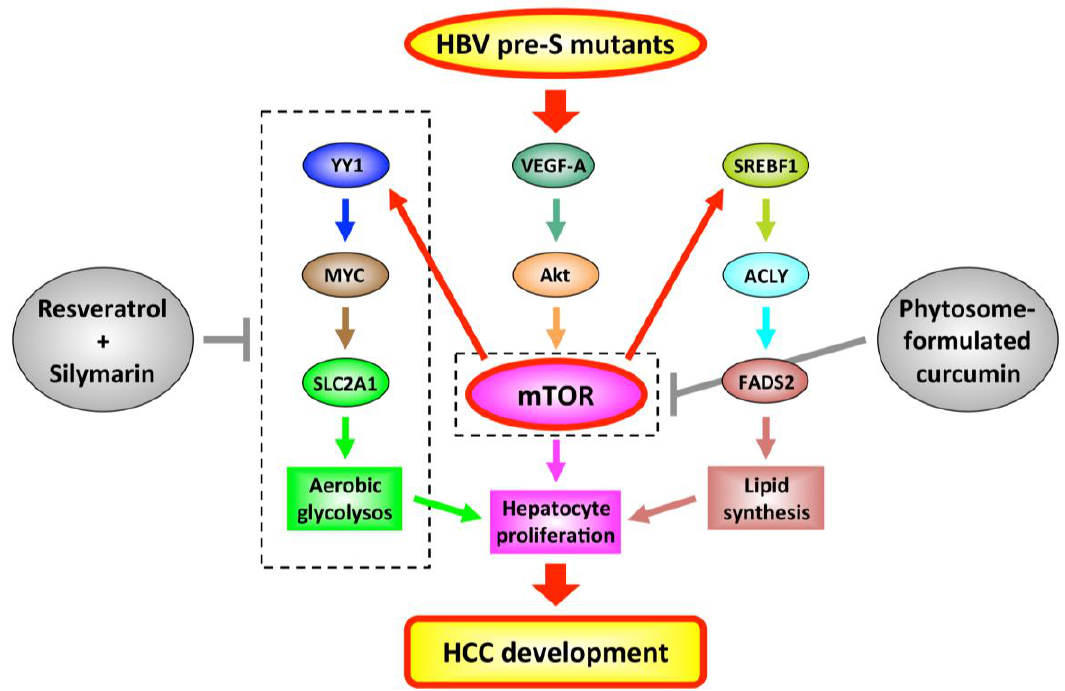
Figure 1. Schematic representation of HBV pre-S mutants-activated mTOR signal pathways as potential targets for HCC chemoprevention. In chronic HBV infection, pre-S mutants can upregulate the expression of vascular endothelial growth factor-A (VEGF-A) in GHHs. Through binding to its cognate receptor, the upregulated VEGF-A functions in either autocrine or paracrine manners to activate mTOR via mediation of Akt activation. The activated mTOR can promote hepatocyte proliferation directly or indirectly, by initiating two metabolic pathways, one involving Yin Yang 1 (YY1) / MYC / solute carrier family 2 (facilitated glucose transporter) member 1 (SLC2A1) to induce aerobic glycolysis, and another involving sterol regulatory element-binding factor 1 (SREBF1) / adenosine triphosphate citrate lyase (ACLY) / fatty acid desaturase 2 (FADS2) to stimulate lipid synthesis. Combined e ff ects of hepatocyte proliferation, aerobic glycolysis, and lipid synthesis will potentially result in HCC development. By means of blocking the pre-S mutants-activated mTOR signal pathways, treatment of either the resveratrol combined with silymarin or the phytosome-formulated curcumin exhibits potential e ffi cacy in preventing HCC development. Abbreviations: HBV, hepatitis B virus; VEGF-A, vascular endothelial growth factor-A; mTOR, mammalian target of rapamycin; YY1, Yin Yang 1; SLC2A1, solute carrier family 2 (facilitated glucose transporter) member 1; SREBF1, sterol regulatory element-binding factor 1; ACLY, adenosine triphosphate citrate lyase; FADS2, fatty acid desaturase 2; HCC, hepatocellular carcinoma.